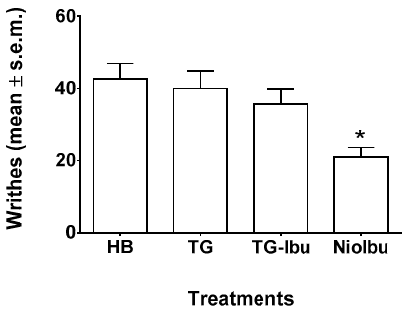
Figure 3. Effects of Hepes buffer (HB), the unstructured surfactant formulation (TG), the unstructured surfactant formulation with the same Ibuprofen (IBU) concentration (TG-Ibu), and TW20-Gly loaded with IBU (NioIbu) on the number of writhes induced by acetic acid. Samples were subcutaneously injected 120 min before acid acetic injection. * is for P < 0.05 versus TG. N = 8.